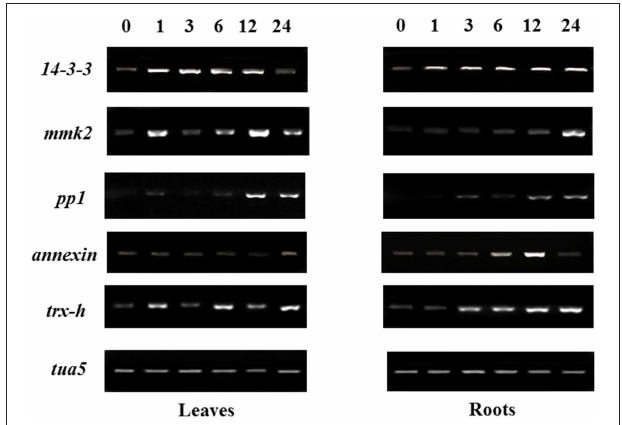
FIGURE 6 | Gene expression analysis of salt responsive proteins identified from the iTRAQ assay. After treated soybean seedlings with 200mM NaCl for 0 (control), 1, 3, 6, 12, 24 h, leaves and roots were harvested for semi-quantitative RT-PCR, and tua5 gene was used as internal RNA reference in leaves and